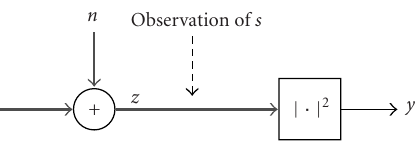
Figure 11: Squaring a noisy complex